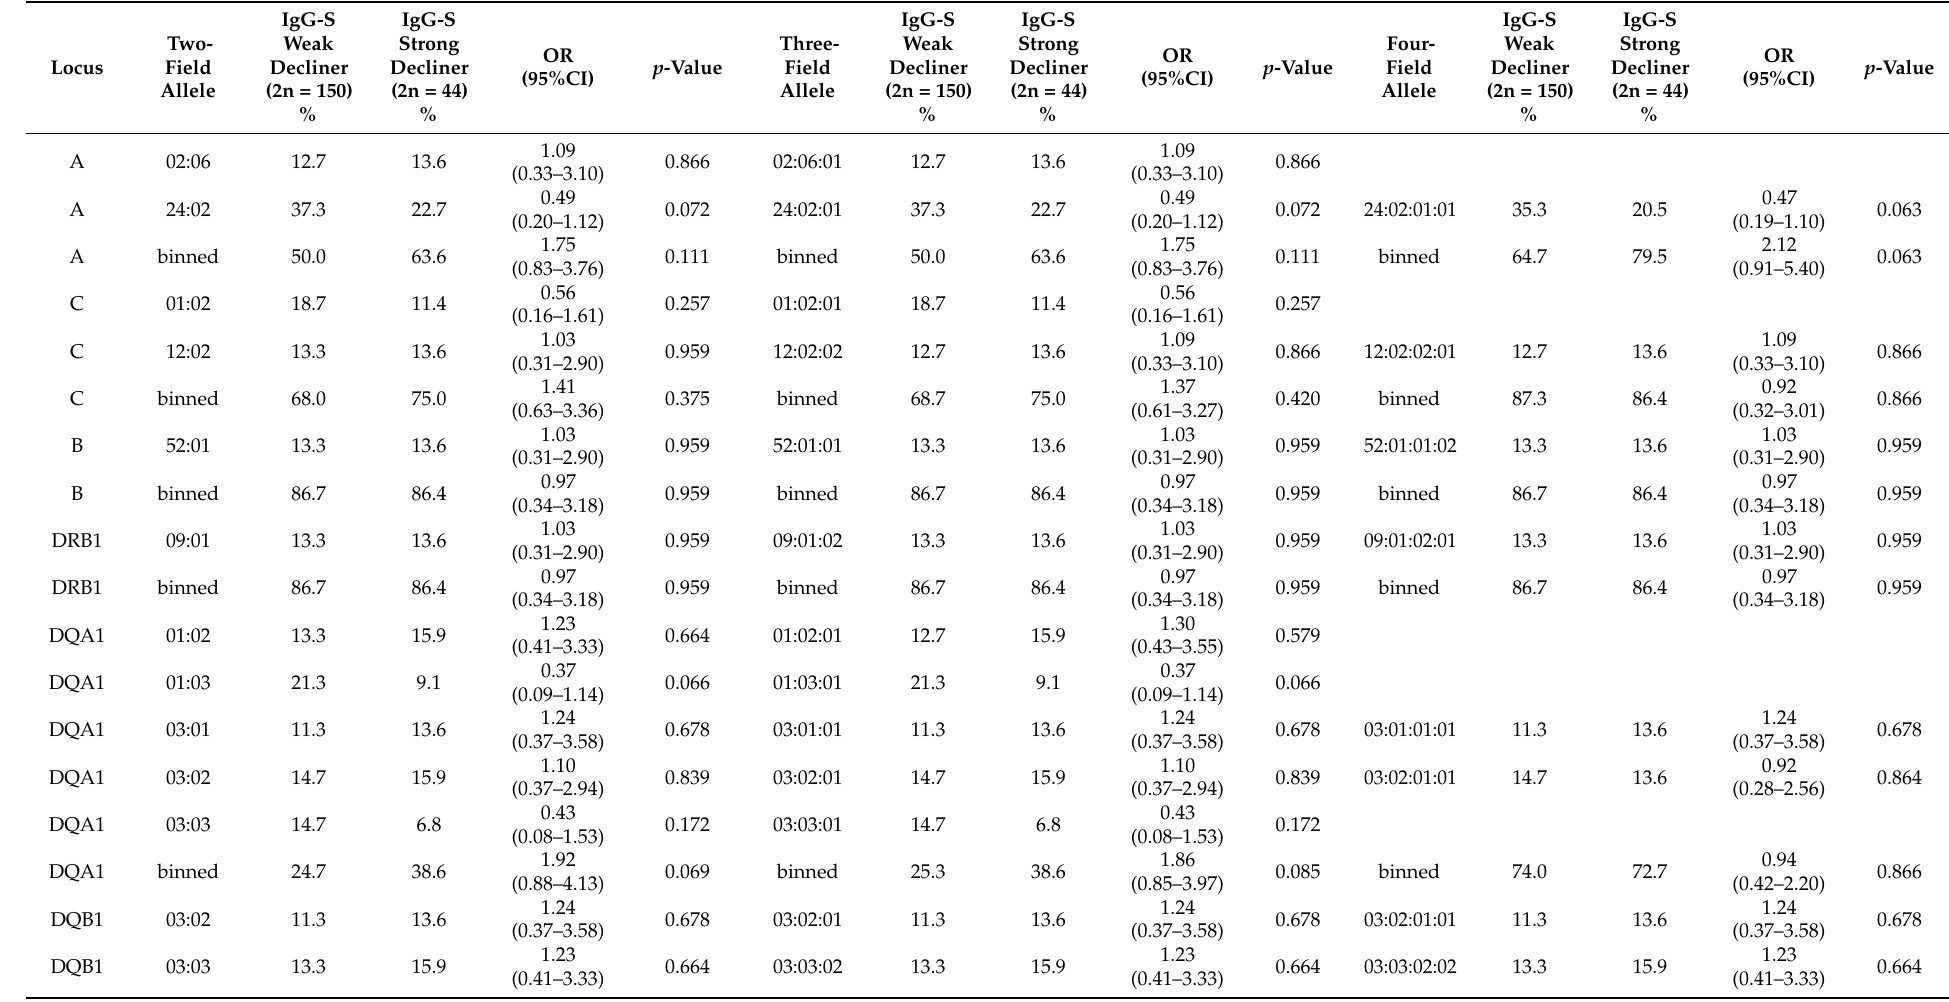
Table 4. Associational analysis of HLA-A, -C, -B, -DRB1, -DQB1, -DOA1 and -DPB1 alleles in 75 IgG-S weak decliner and 22 IgG-S strong decliner. Abbreviations: OR, odds ratio; 95%CI, 95% confidence interval; binned, rare HLA alleles with expected count <5 are combined into a common